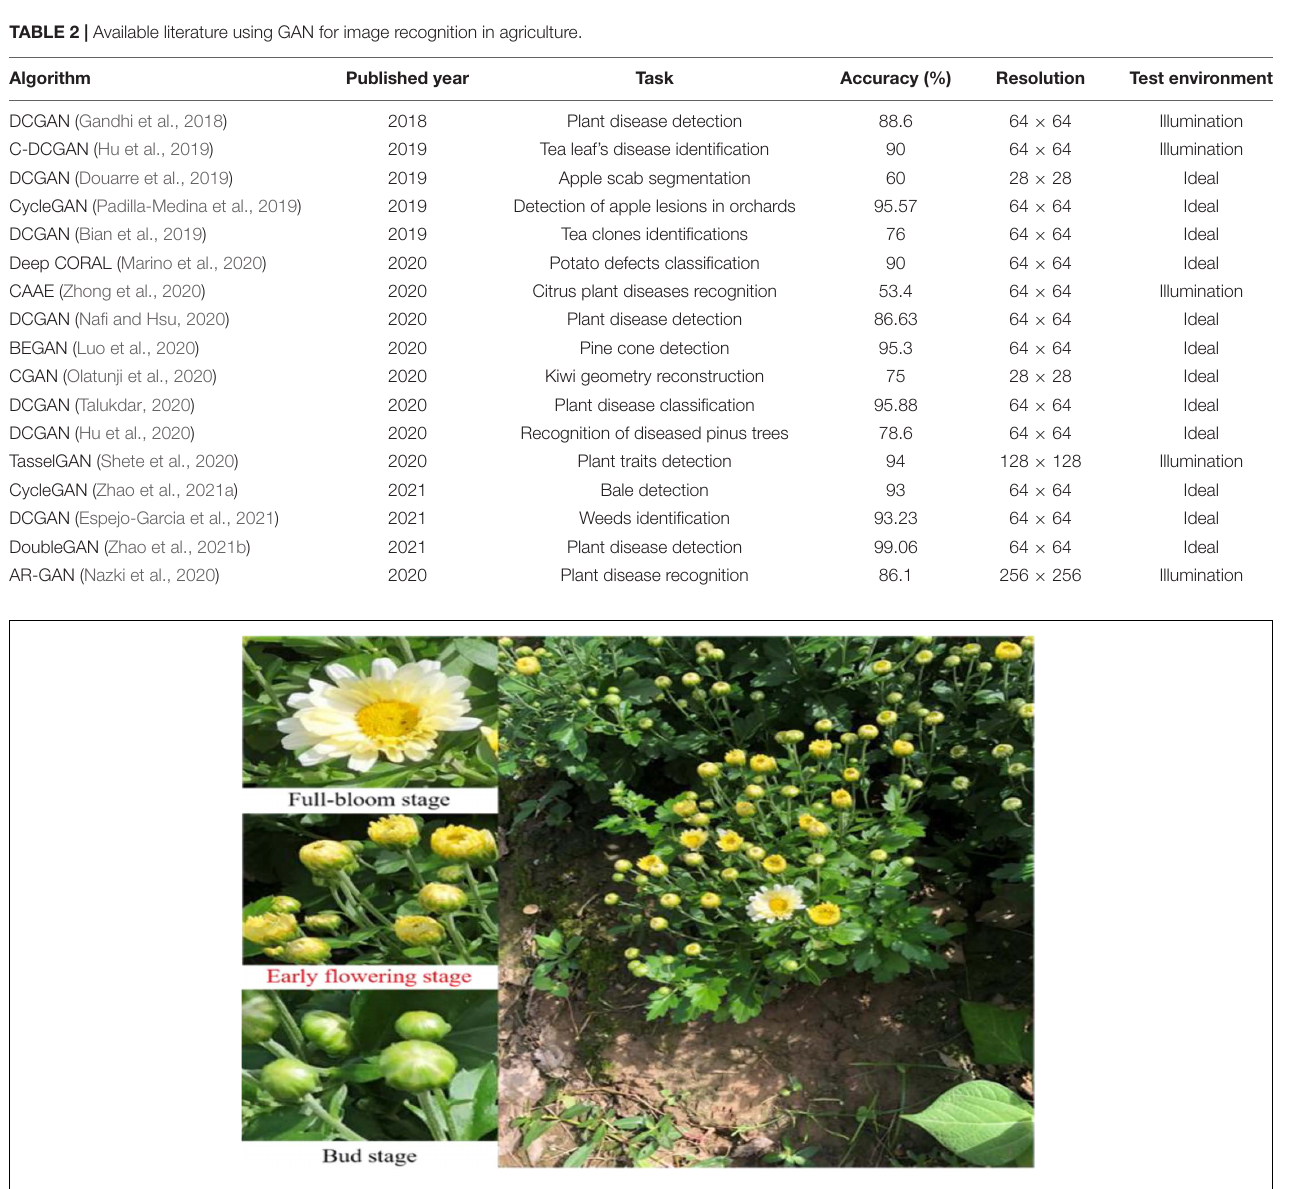
FIGURE 2 | Examples of the collected original images.